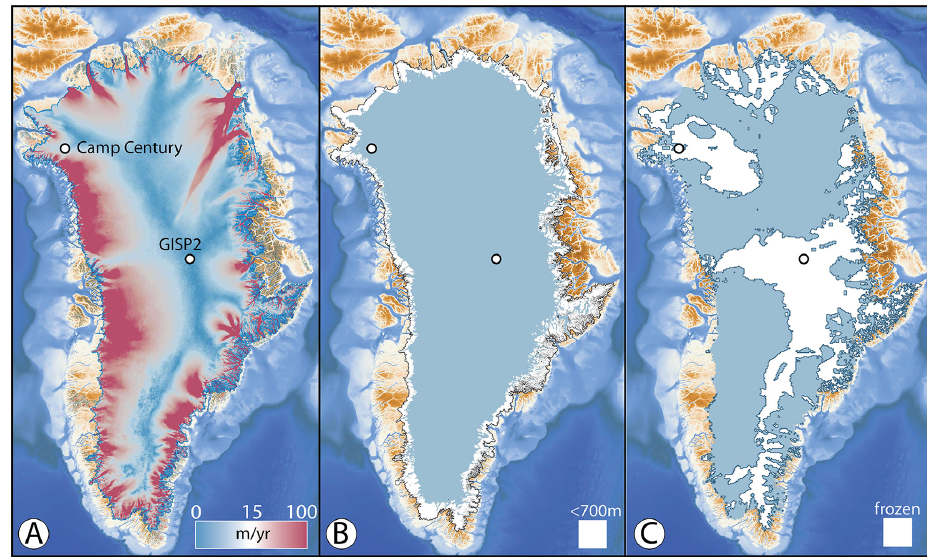
Figure 1. (a) Horizontal surface velocities of the Greenland Ice Sheet; the slowest flowing areas define the summit ridge and ice divides; velocity from Greenland Ice Sheet velocity map from Sentinel-1, winter campaign 2019/2020 (version 1.3); QGreenland v2.0. (b) The pattern of < 700m ice thickness (white) shown around perimeter of the ice sheet, which covers 15.2% of the ice-sheet footprint. (c) Where the basal thermal state is likely frozen bedded (white), which covers 37.4% of the ice-sheet footprint (from MacGregor et al., 2022). Basemap topography and bathymetry from Morlighem et al.